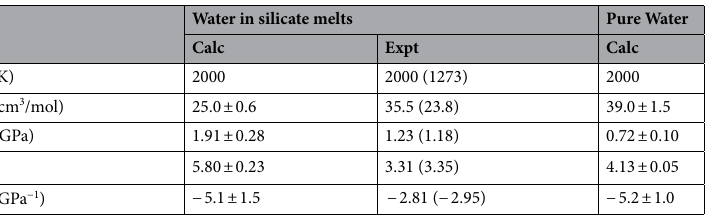
Table 2. Equation of state parameters at 2000 K for the water dissolved in silicate melts by considering together the results for all hydrous iron-free melts (MgSiO 3 with 8.2 wt% water, Mg 2 SiO 4 with 6.0 and 11.4 wt% water). The experimentally inferred parameters are from Sakamaki 10 . The parameters for pure liquid water correspond to a non-zero constant pressure (0.5